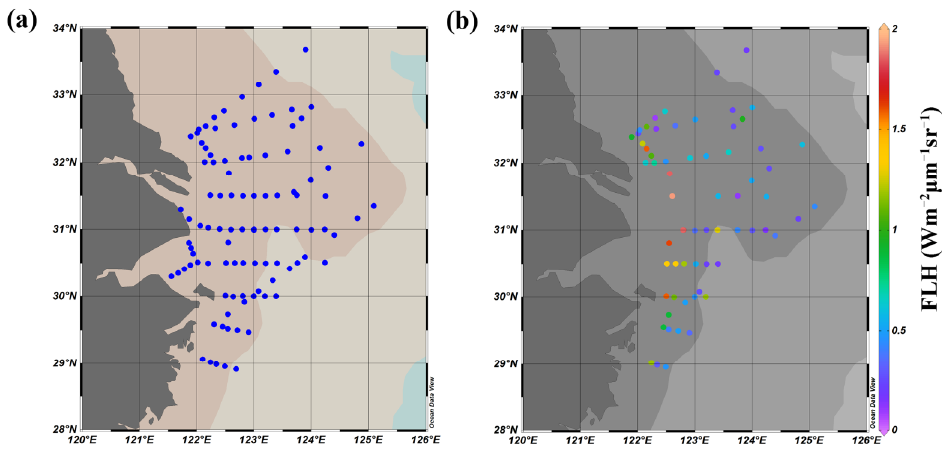
Figure 2. Sampling stations of two cruises in the East China Sea in 2016. ( a ) All measurement stations. ( b ) Stations with effective FLH data.